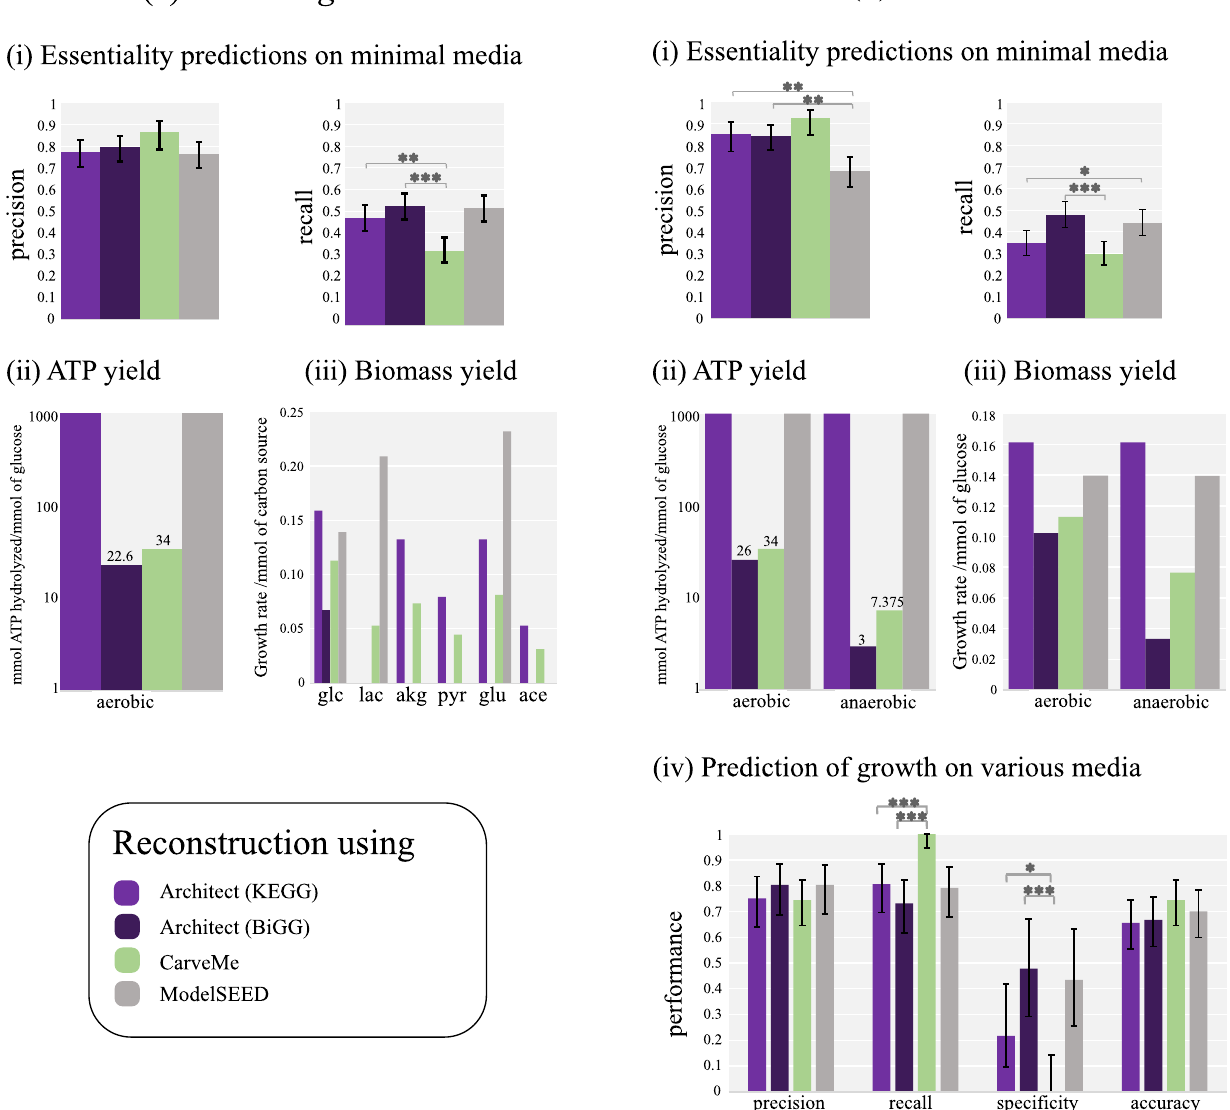
Fig 4. Comparison of simulation results of Architect, CarveMe and ModelSEED in (a) N . meningitidis and (b) E . coli . Panel (i) shows the performance of each tool in predicting essential genes in minimal media. Yield of ATP and biomass are shown in panels (ii) and (iii) given 1 mmol of glucose and alternate carbon sources in N . meningitidis , and under presence and absence of oxygen in E . coli . Panel (iv) shows the performance of individual tools in predicting the capacity to grow on alternate media. Error bars show the 95% confidence interval for individual performance measures, each considered as the estimate of a binomial parameter. In those cases, p-values are computed using Fisher’s exact test and only between Architect-BiGG or Architect-KEGG and other tools (with � , �� and ��� representing p less than 0.05, 0.005 and 0.0005